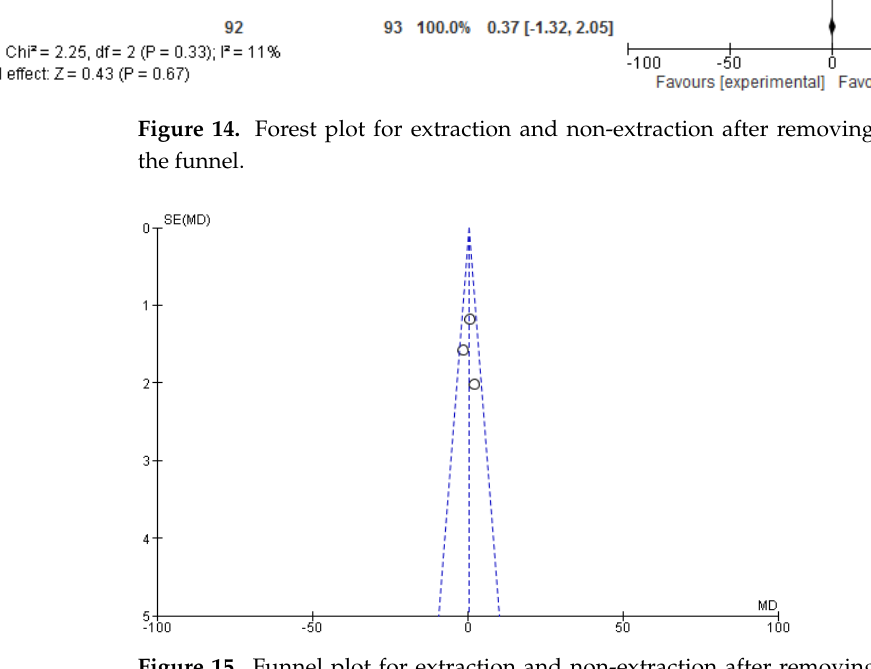
Figure 15. Funnel plot for extraction and non-extraction after removing the studies lies outside the funnel.